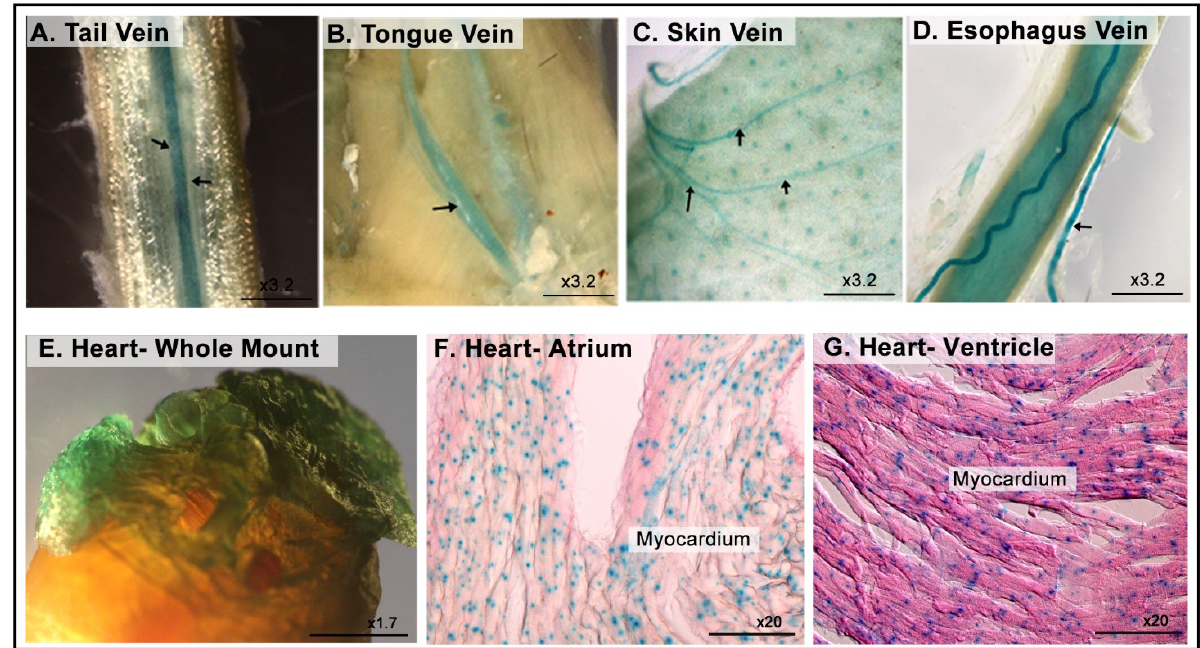
Figure 8. LacZ expression in the cardiovascular system. ( A – D ) Whole-mount LacZ staining of the veins collected from the tail, tongue, skin, and esophagus. ( E – G ) LacZ staining in the heart, showing uniform staining at the atrium and ventricle myocardium.